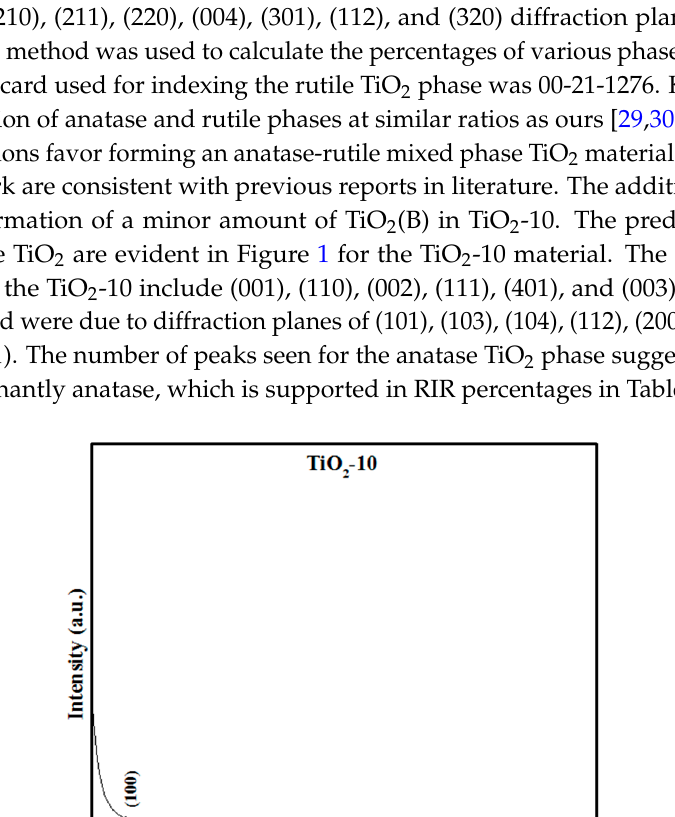
2 as function of